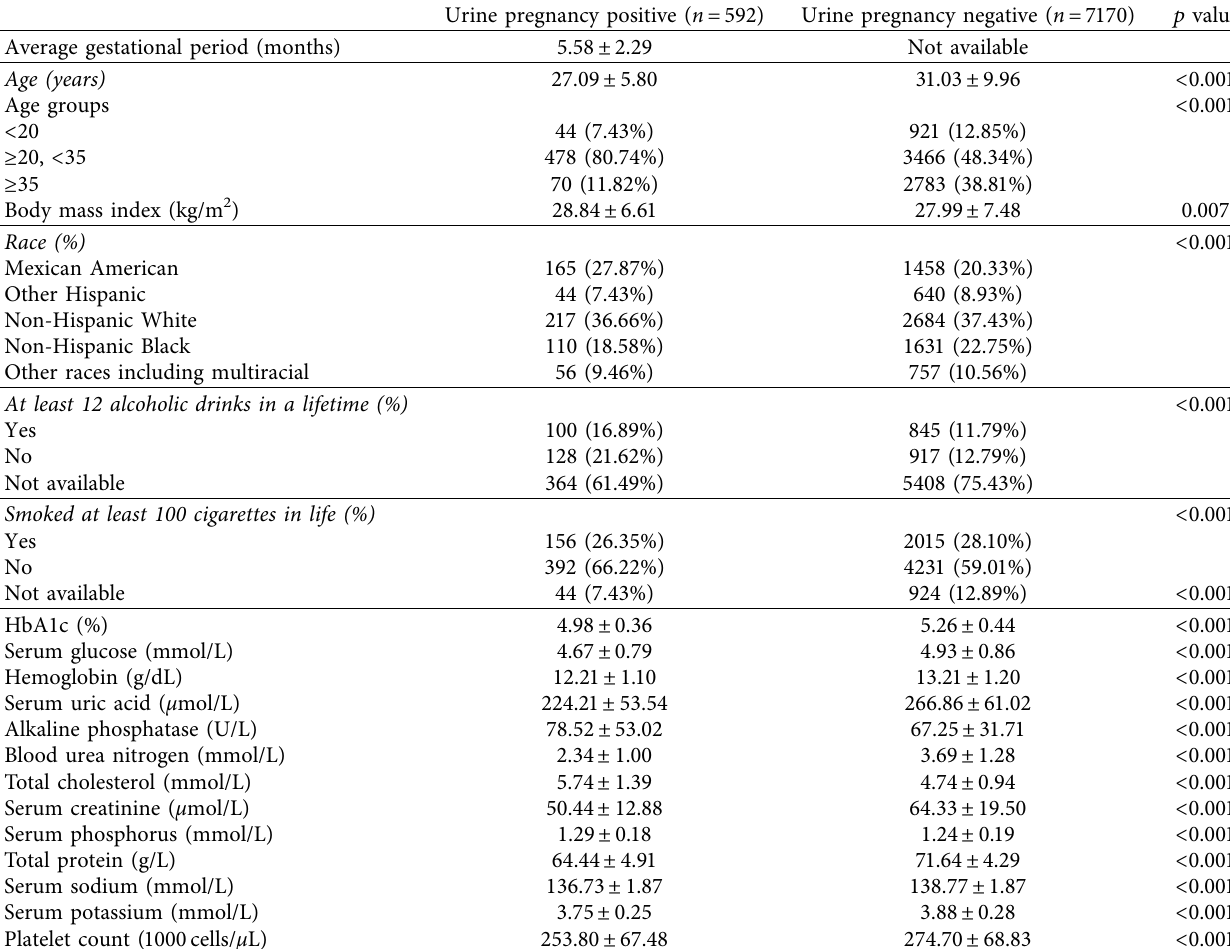
Table 1: Weighted characteristics of the study sample with and without pregnancy in nondiabetes women.